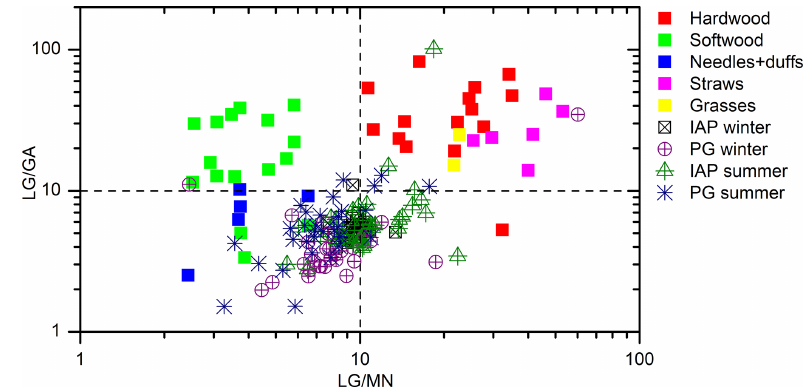
Figure 3. Scatter plot of LG / MN vs. LG / GA from different types of biomass burning emissions (Cheng et al., 2013; Sun et al., 2019a,b; LG, MN, and GA refer to levoglucosan, mannosan, and galactosan, respectively), including those measured in PM 2 . 5 samples at IAP and PG during winter and summer. The range of LG / MN is 7.66–13.41 and 5.48–22.40 for IAP in winter and summer and 2.45–60.20 and 3.27–17.71 for PG in winter and summer, while the range of LG / GA is 3.98–6.92, 2.78–101.43, 1.97–34.66, and 1.51–13.39,